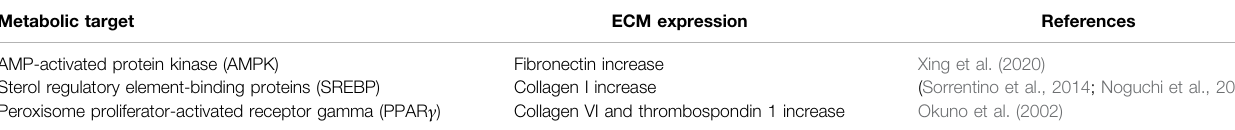
TABLE 1 | Metabolic pathways regulating ECM expression.